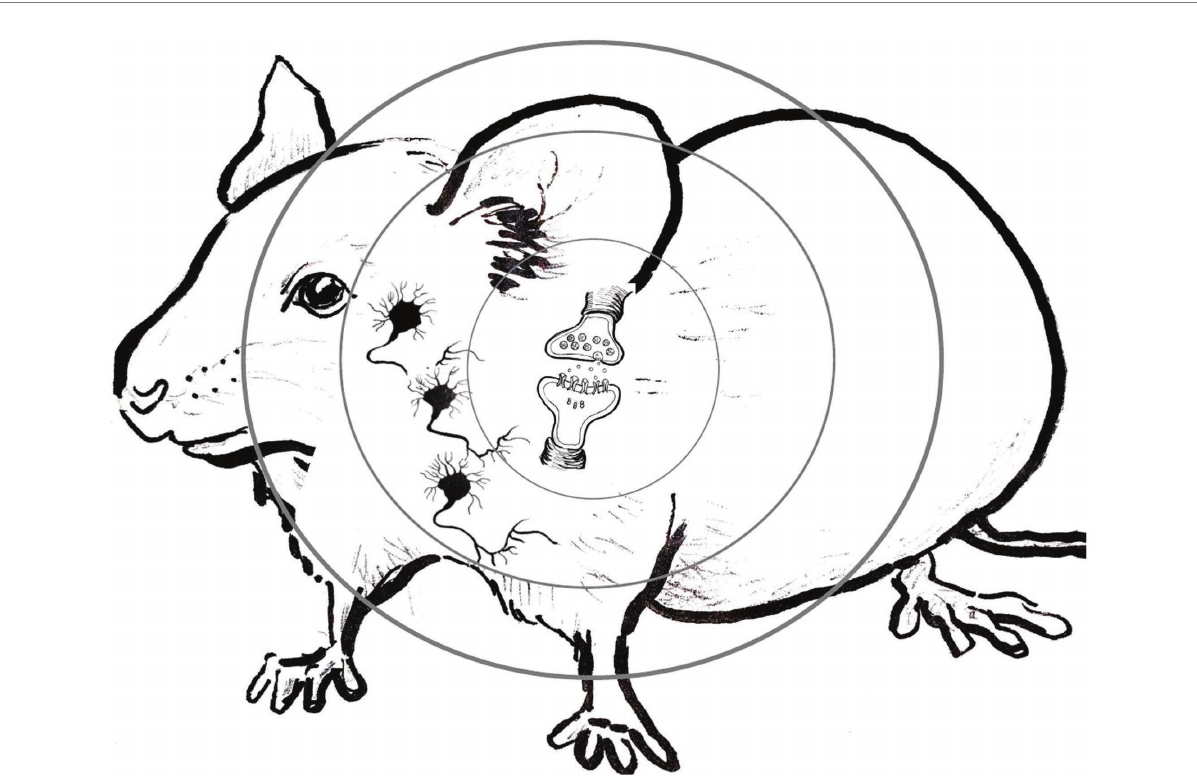
FIGURE 2 The “outwards” levels-less image of the behaving organism suggested by results using the new research tools of molecular and cellular cognition (MCC), with myriad causal relations obtaining between intra- and intercellular molecular pathways (innermost concentric circle), cells and networks of cells (middle concentric circle), and the behaving organism (outermost concentric circle; Original artwork by Caroline